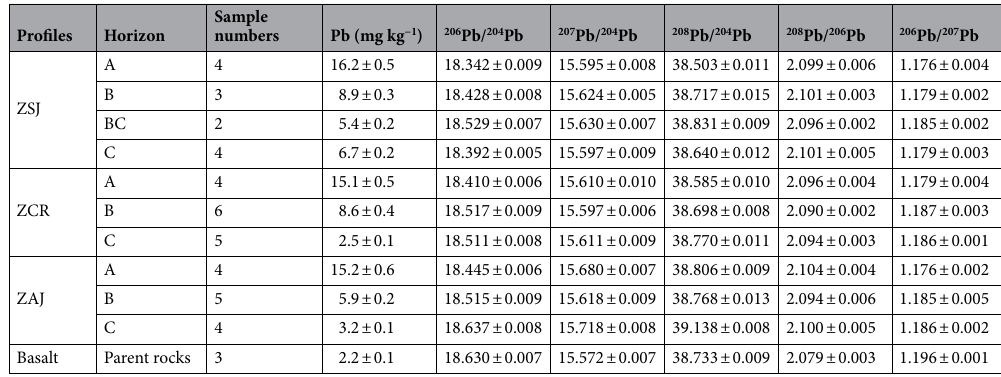
Table 2. Lead concentrations and isotopic composition in